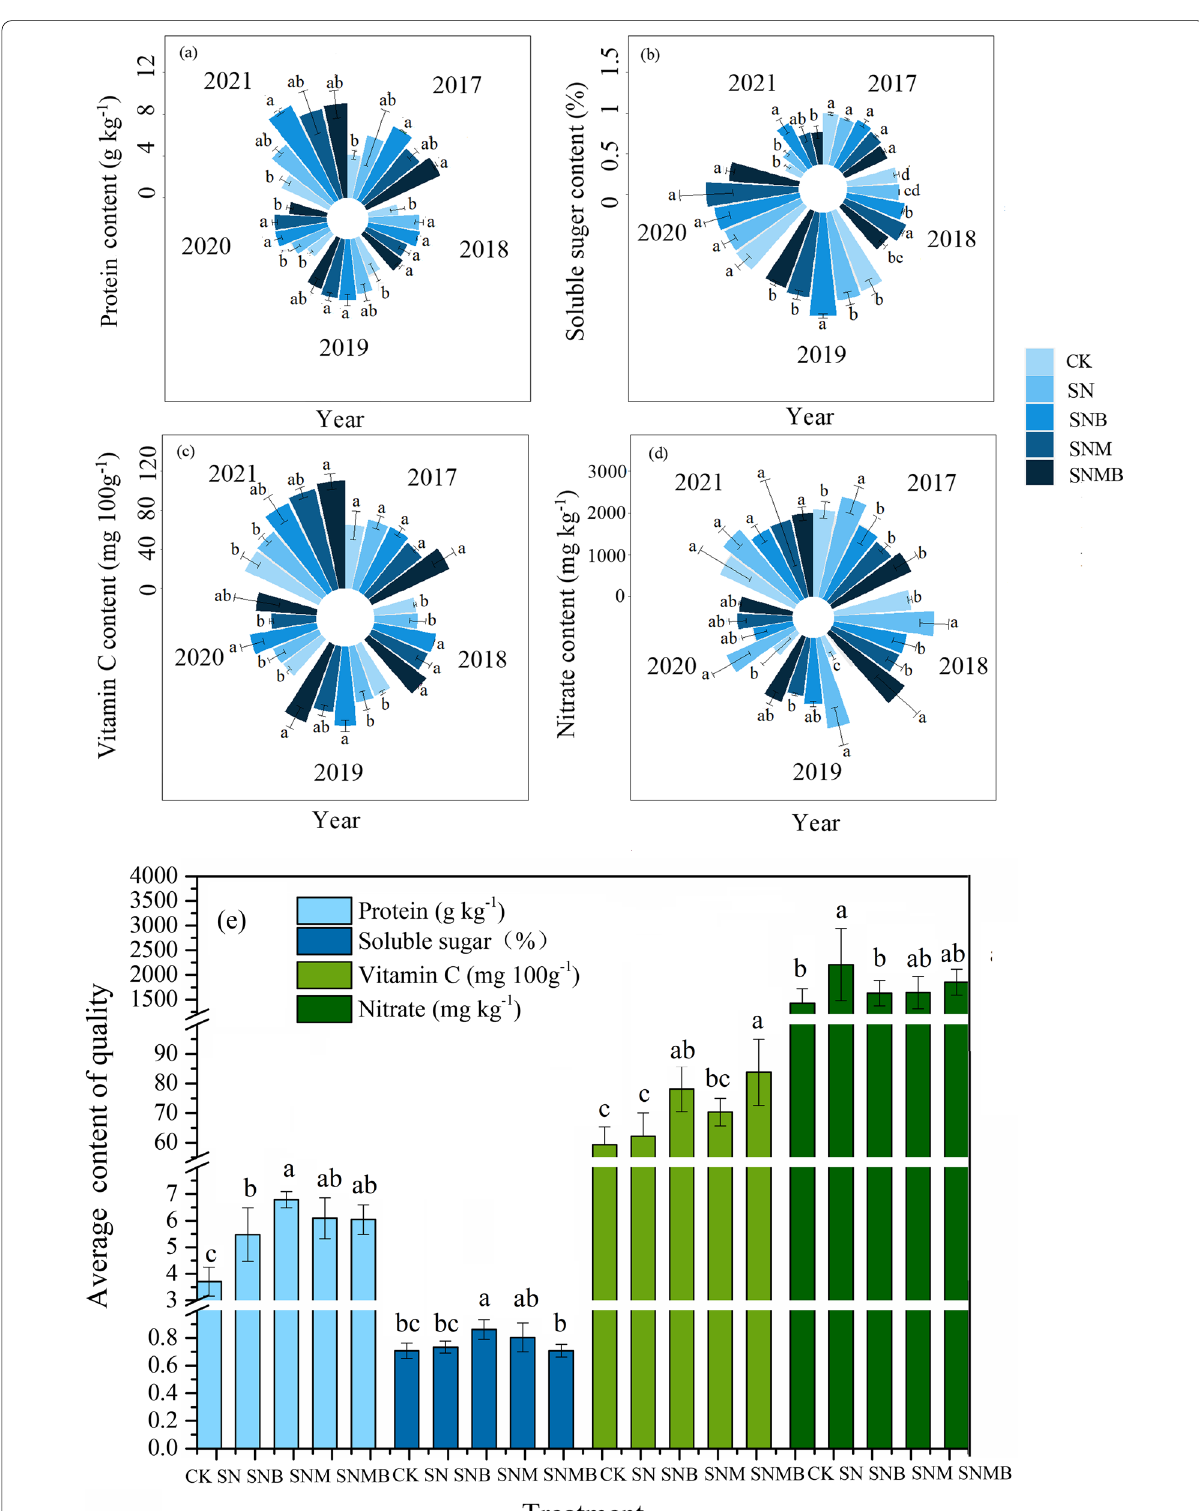
Fig. 4 Quality (protein, soluble sugar, vitamin C, and nitrate) of vegetables under different treatments and years in intensive vegetable production. Different letters above the bars indicate significant differences among the different treatments at p < 0.05. Bars indicate the standard deviation (mean SD, n ± =